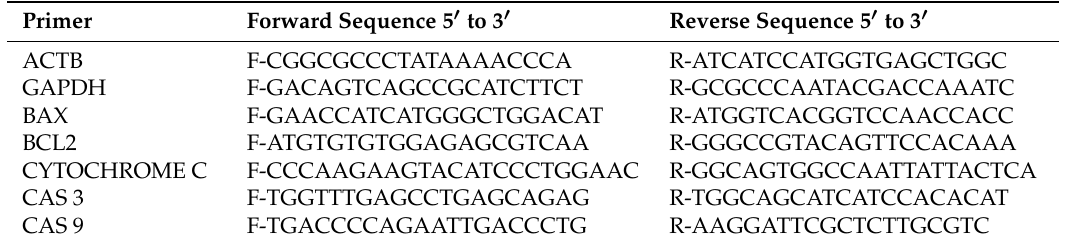
Table 1. Primer sequences used in quantitative polymerase chain reaction